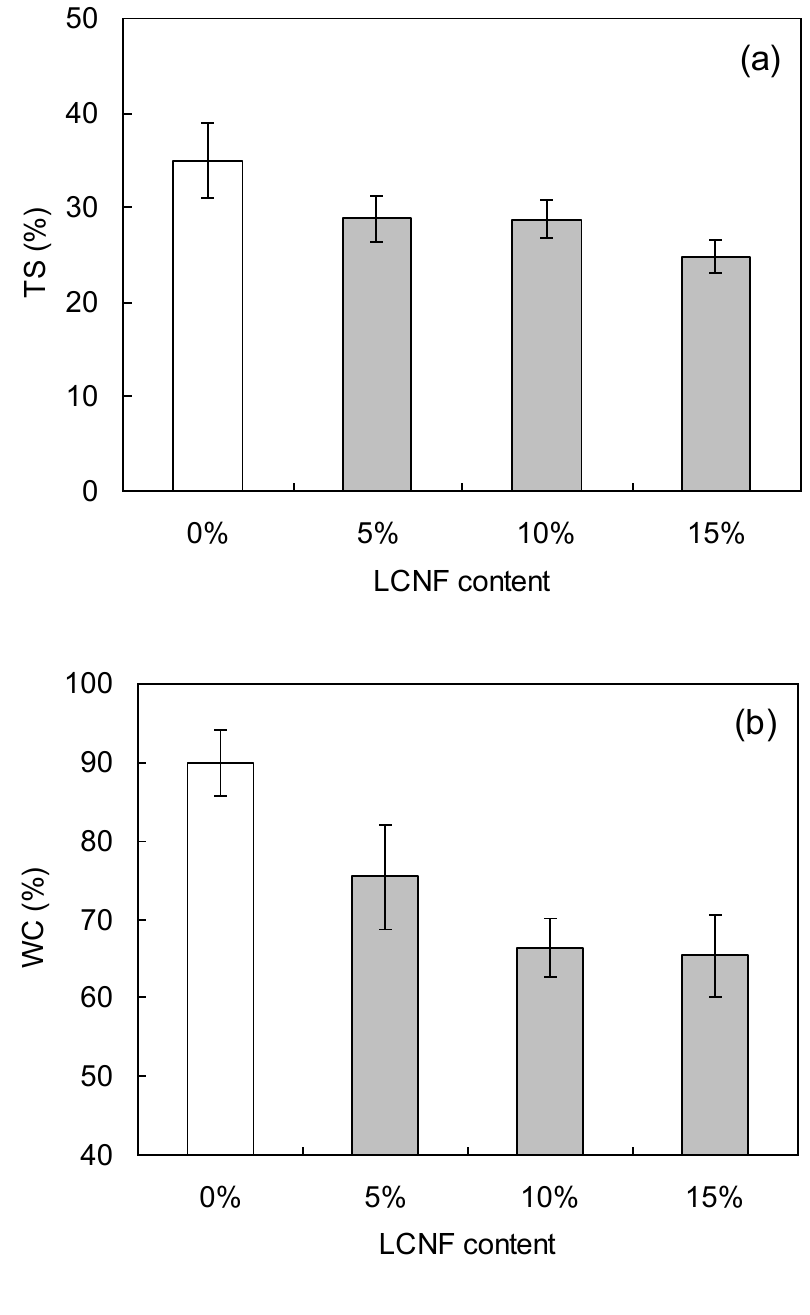
Figure 6. ( a ) TS and ( b ) WC of wood flour/LCNF composites are given following water absorption as a function of LCNF content. The vertical bars indicate a single standard